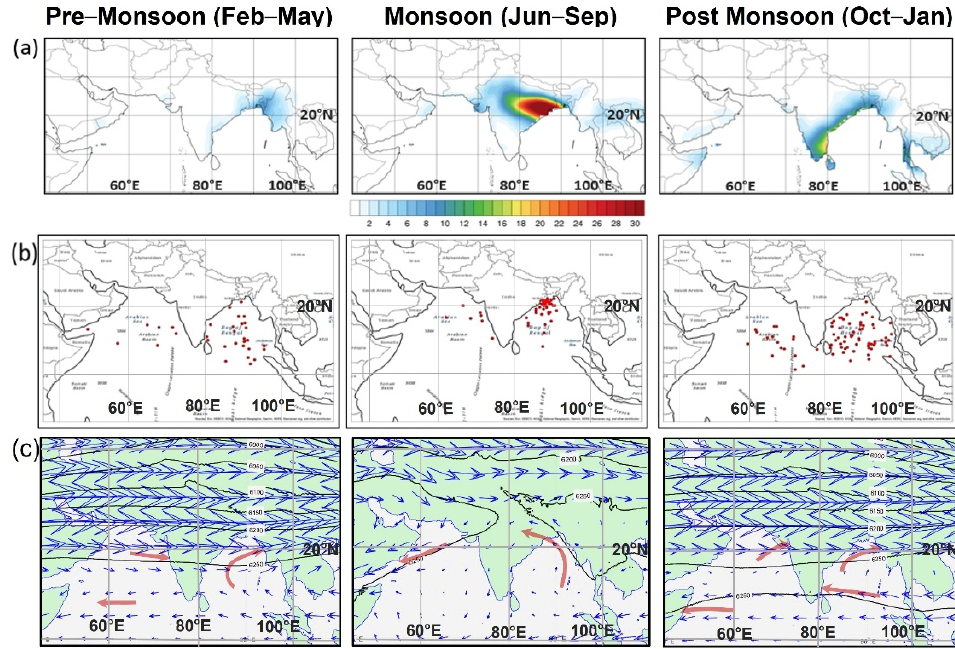
Figure 4. Patterns separated by Monsoon phase: ( a ) landfalling TC track density; ( b ) TC genesis locations indicated by red dots; and ( c ) 30-year average 200–850 hPa deep layer steering flow (blue vectors) and 500-hPa geopotential heights (black contours) for the pre-monsoon (left column), monsoon (middle column), and post-monsoon (right column). Red arrows in panel ( c ) indicate the prevailing steering flow.